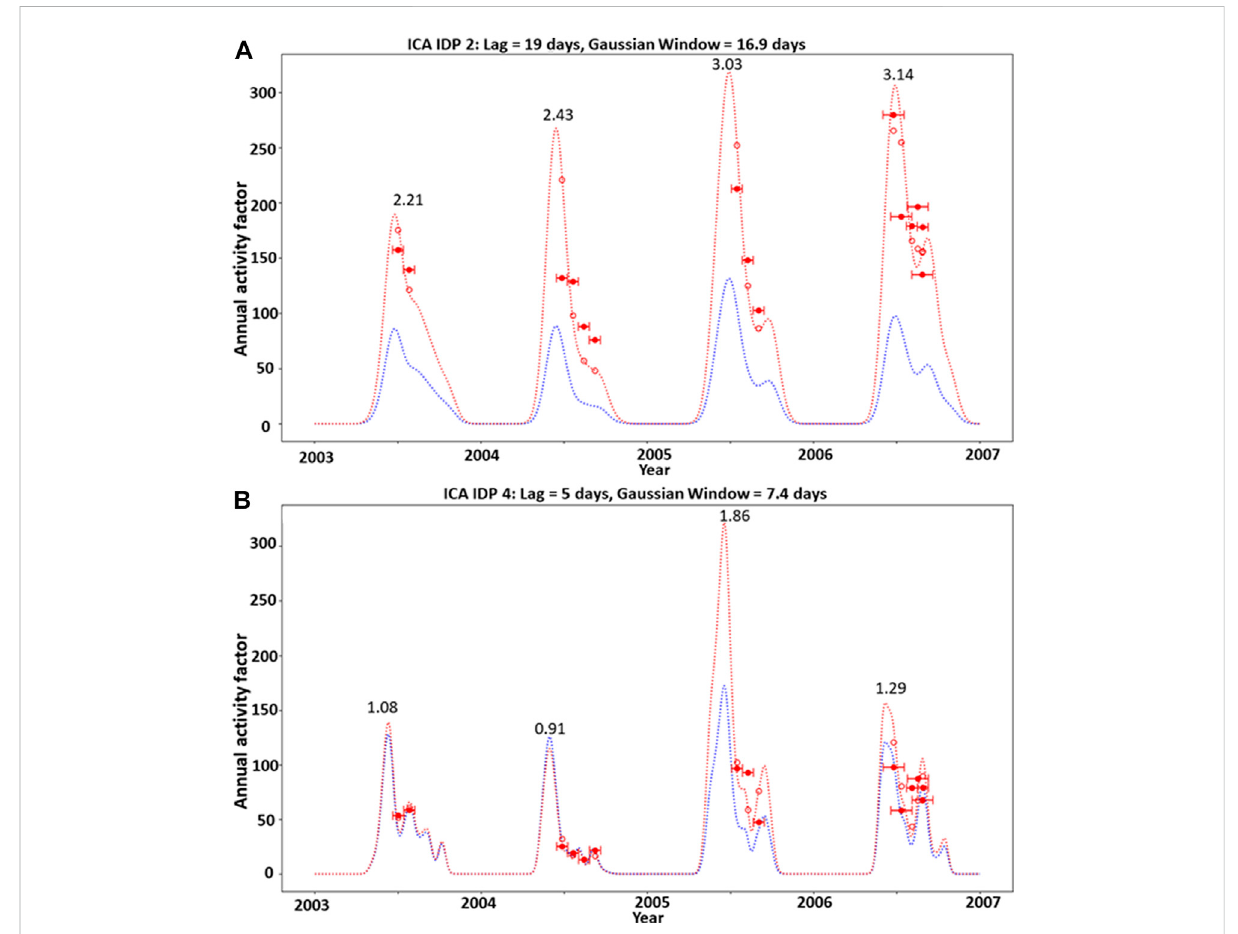
FIGURE 12 Short-term temporal correlation of displacement pattern intensity and effective driver series for the examples of (A) IDP 2 and (B) IDP 4. Shown aretheIDPintensities(reddots),theeffective( fi lteredandpropagated) hydrologicaldriver(bluedashedline),andtheseasonallylinear fi ttedeffective driver (red dashed line) for the period 2003 – 2007. Numbers are the multiplicative factors required to turn the blue curve into the red curve (annual